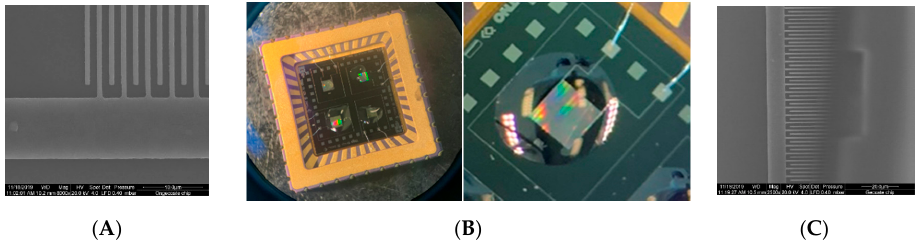
Figure 2. Images of an interdigitated electrode: ( A ) SEM image of empty electrode; ( B ) optical image of a (BioSpot) coated chip, before drying; ( C ) SEM image of a coated electrode (part is burned o ff by SEM electron